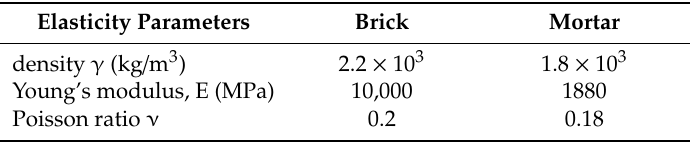
Table 8. Mechanical properties of masonry unit and mortar.